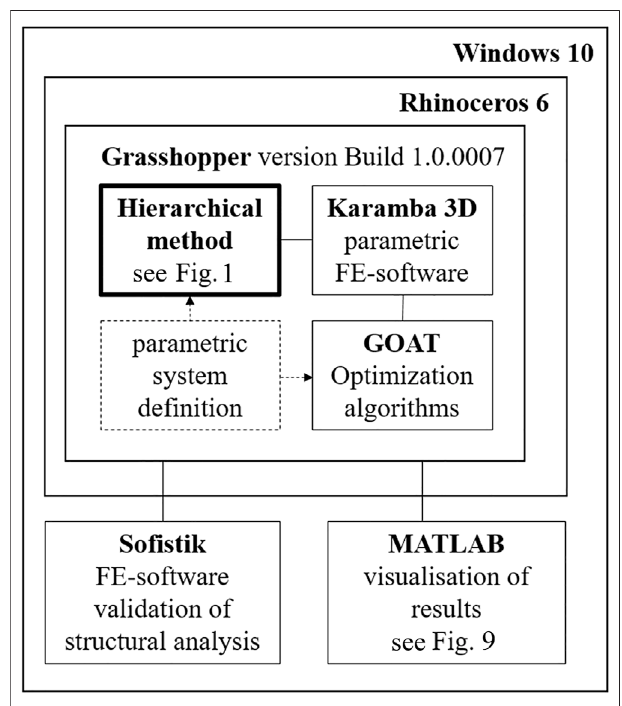
FIGURE 3 | Software environment in the framework of the